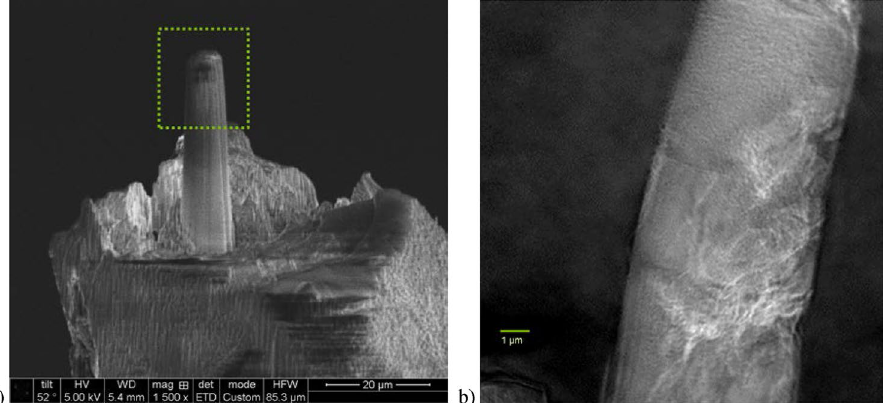
Figure 5. Preparation and X-ray image of tooth sample. ( a ) SEM micrograph of focused ion beam milled piece of tooth sample prepared for high resolution X-ray imaging. Dotted rectangle indicated region imaged. ( b ) First